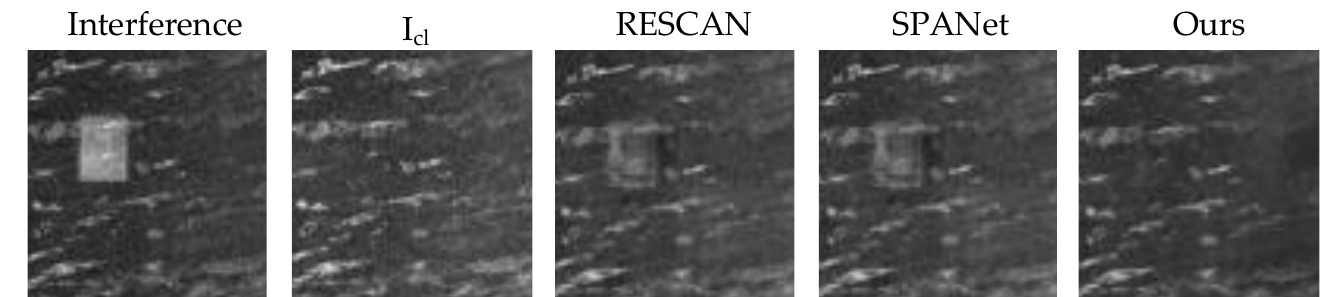
Figure 11. The region of interest for enlarged display in (c) of Figure 9.